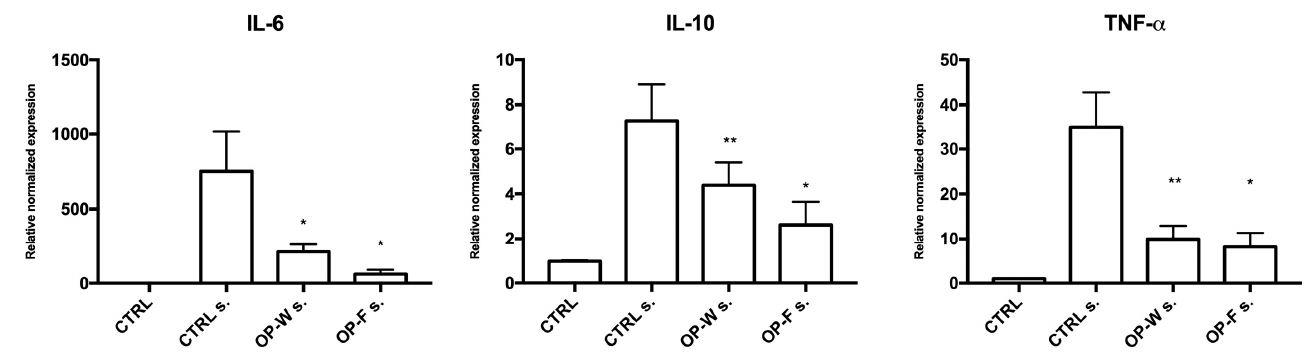
Figure 2. Real time PCR relative quantification of mRNAs encoding IL-6, IL-10, and TNF- α ( ± S.E.M.), evaluated in human PBMCs after stimulation (s) or not (n.s.) with LPS for 2 h in an incubator at 37 °C, 5% CO 2 . Blood cells were previously cultured in presence or not (CTRL) of aqueous extracts obtained from OP (OP-W and OP-F) after in vitro digestion and dialysis. * p < 0.05, ** p < 0.01.